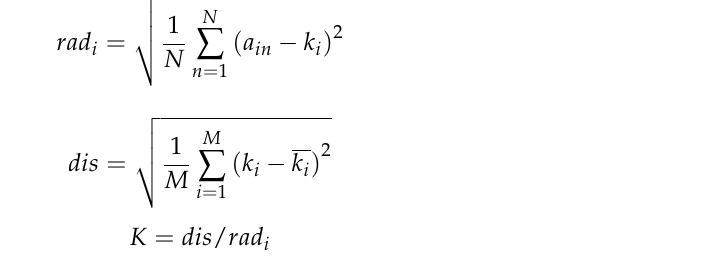
Table 1. Cluster index K of control predictions ( K con ) and ensemble forecasts ( K ens ).